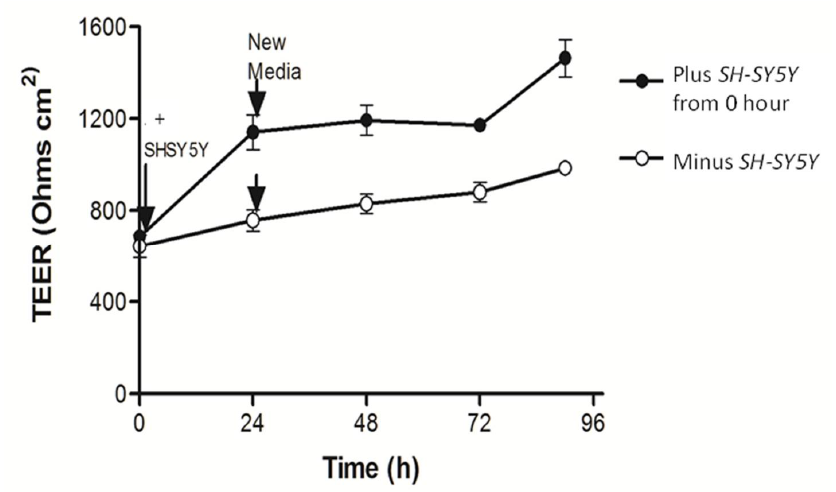
Figure 6. SH-SY5Y cells underneath cause tighter junctions between Caco2bbe1 cells on inserts. Caco2BBe1 cells were plated on inserts ( n = 25,000/insert) and grown with regular feeding of complete (10% FBS) media, top and bottom. On day 11, SH-SY5Y cells were plated at high density in separate open 24-well plates ( n = 25,000/well) in complete media. Four days later, both 24-well plates were refed complete media and half the well inserts were transplanted above the SH-SY5Y cells. The experimental variable was presence or (continued) absence of SH-SY5Y cells under the inserts. The measure was daily TEER readings. Three inserts were assessed per condition and the experiment was repeated three times. Evidence that the initial rise in TEER did not owe to the simple replenishment of media is shown by the arrows when fresh complete media was again replaced after 24 h. No elevation in TEER appeared by just replenishing the media. The inserts not transplanted above SH-SY5Y cells never caught up in TEER. Plots are means ± SEMs.